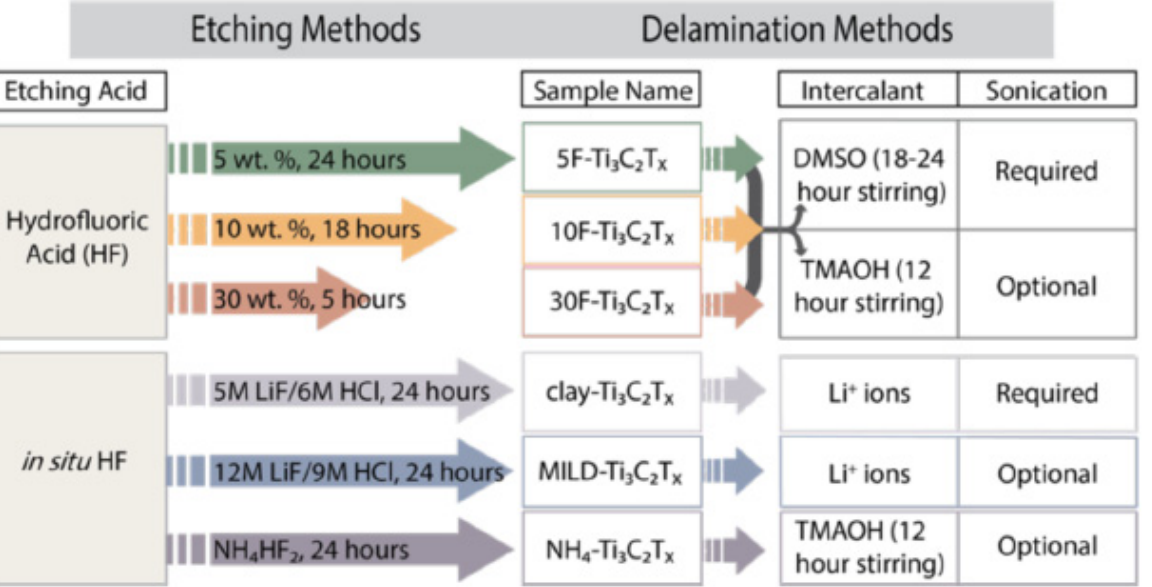
Figure 2. Schematic diagram of the formation of MXene sheets by the exfoliation process of Ti3AlC2. Reproduced with permission from [18]. Copyright 2021 Wiley.